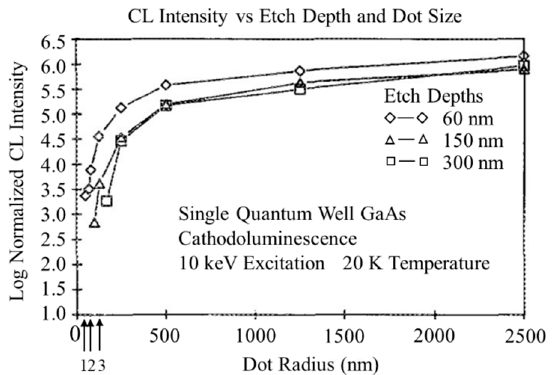
Figure 2. CL intensity of QDs prepared with different etched depths as a function of dot radius. Reproduced with permission from [48]. AIP Publishing, 1989.